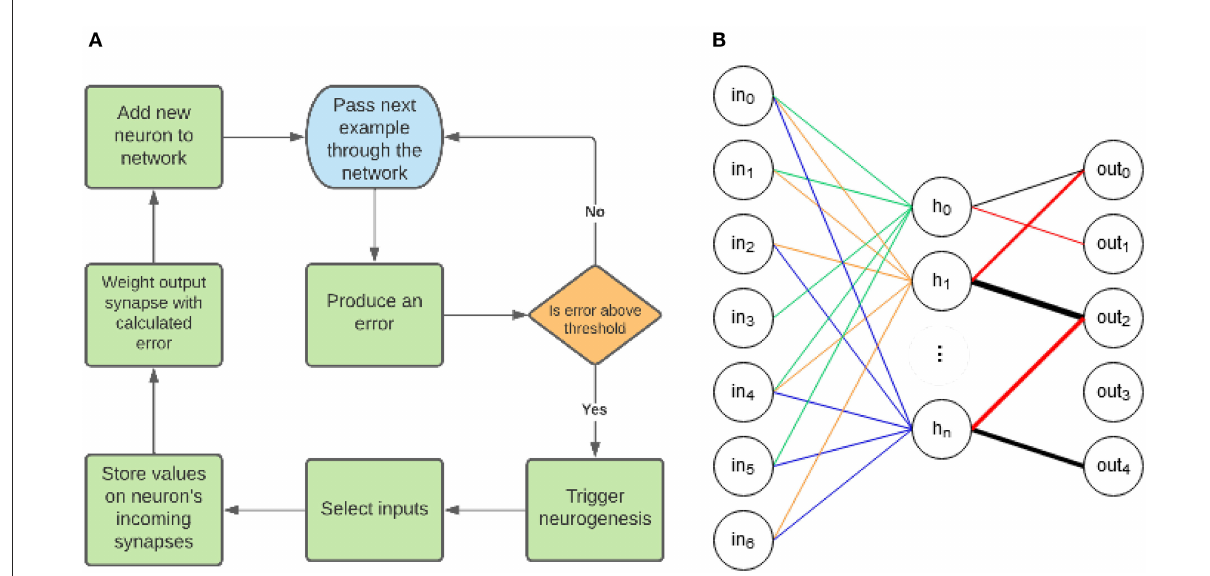
FIGURE1 (A) The general structure of the EDN algorithm. First an input is presented which produces an associated error, if the magnitude of the error is above the error threshold then neurogenesis is triggered. Afferent synapses of the newborn neuron are selected and the values of the current inputs set the center of the kernel function on the synapses. The outputs whose error is above threshold are connected to the new neuron using synapses with weights proportional to the errors produced. (B) An example topology created with EDN. The different colors connected to the hidden neurons signify different sub-sampled input vectors which have been stored on the synapses; they all contribute equally to neuron activity. The color and thickness of connections between the hidden layer and the outputs displays that output connections are weighted and the magnitude can be negative or positive. The weight of these connections is determined during the training process by the error produced when neurogenesis is